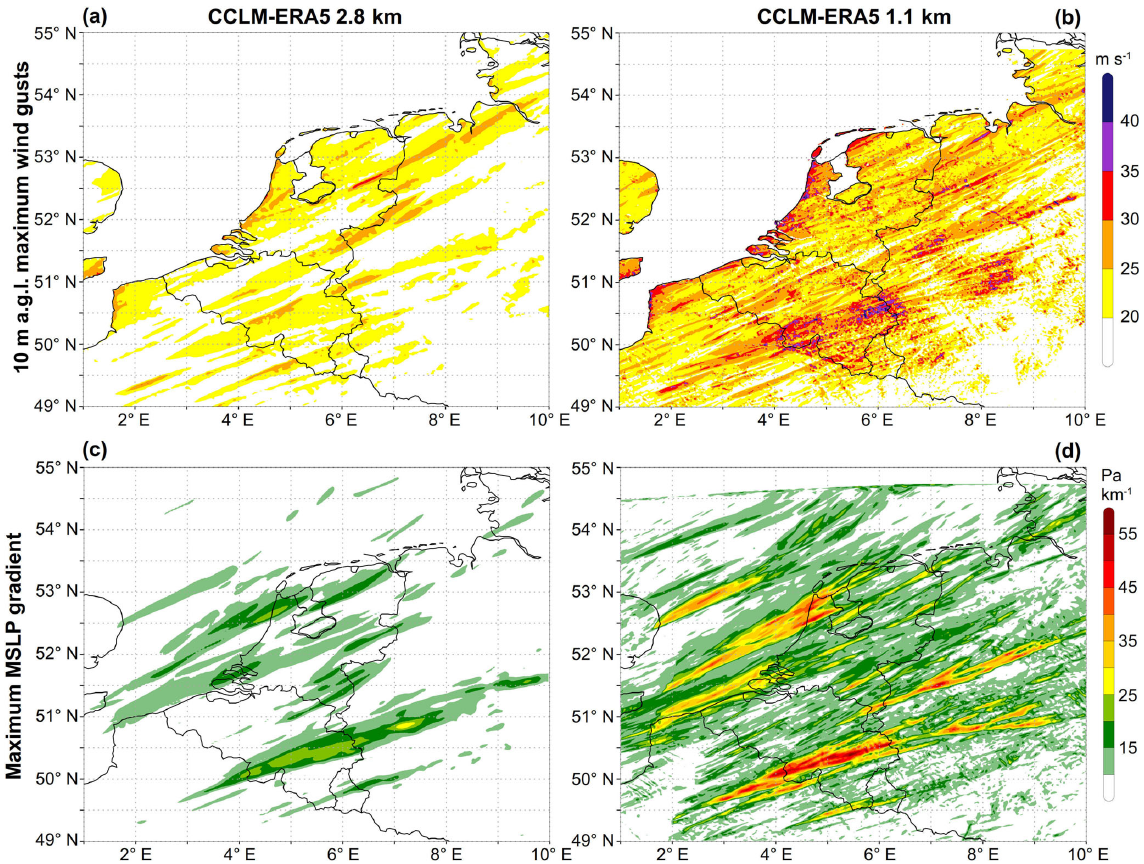
Figure 12. CCLM-ERA5 2.8 and 1.1km simulations of (a, b) 10ma.g.l. maximum wind gusts (ms − 1 ) and (c, d) maximum mean sea level pressure (MSLP) gradient (Pakm − 1 ) between 14:00 and